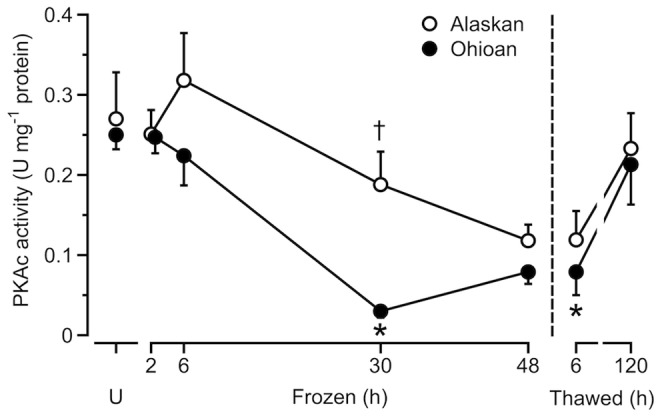
Activity of liver PKAc during freezing and thawing.Activity of hepatic PKAc (mean ± SEM; N = 4–8) in frozen and thawed Alaskan and Ohioan R. sylvatica as compared to that in unfrozen frogs (U). Asterisk indicates that the value differs from the mean for the corresponding sample of unfrozen frogs (Dunnett’s, P<0.05); dagger indicates that the value differs between populations (Bonferroni, P<0.05). Some overlapping values were slightly offset along the abscissa for clarity.